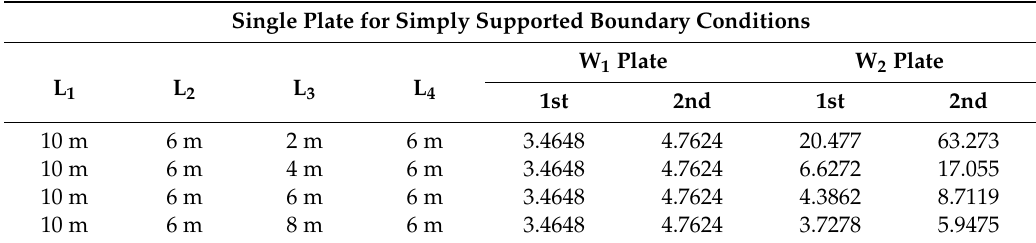
Table 3. FEA Result of single plate for simply supported boundary conditions (unit: